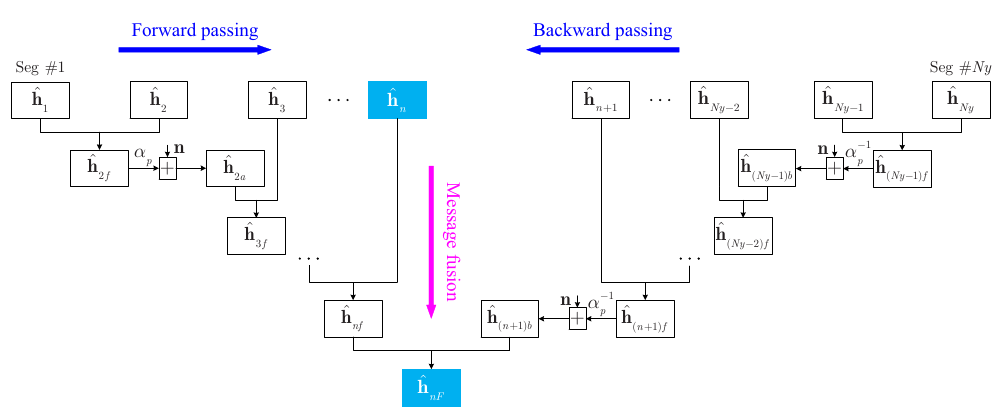
Figure 5. Accurate channel estimation of the n -th